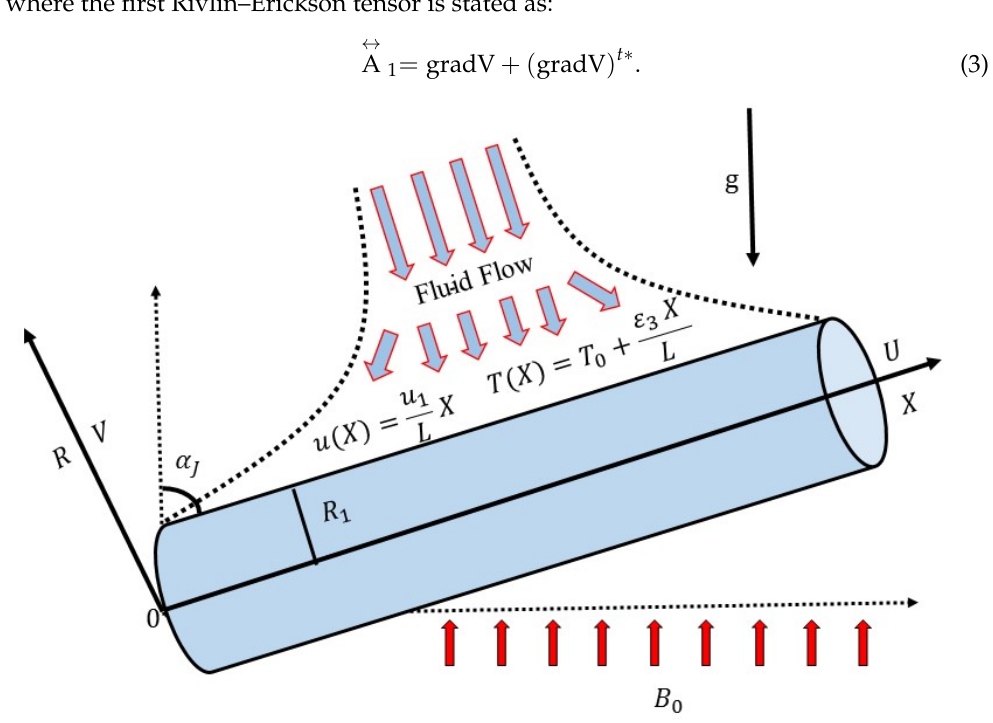
Figure 1. Geometry of the problem.